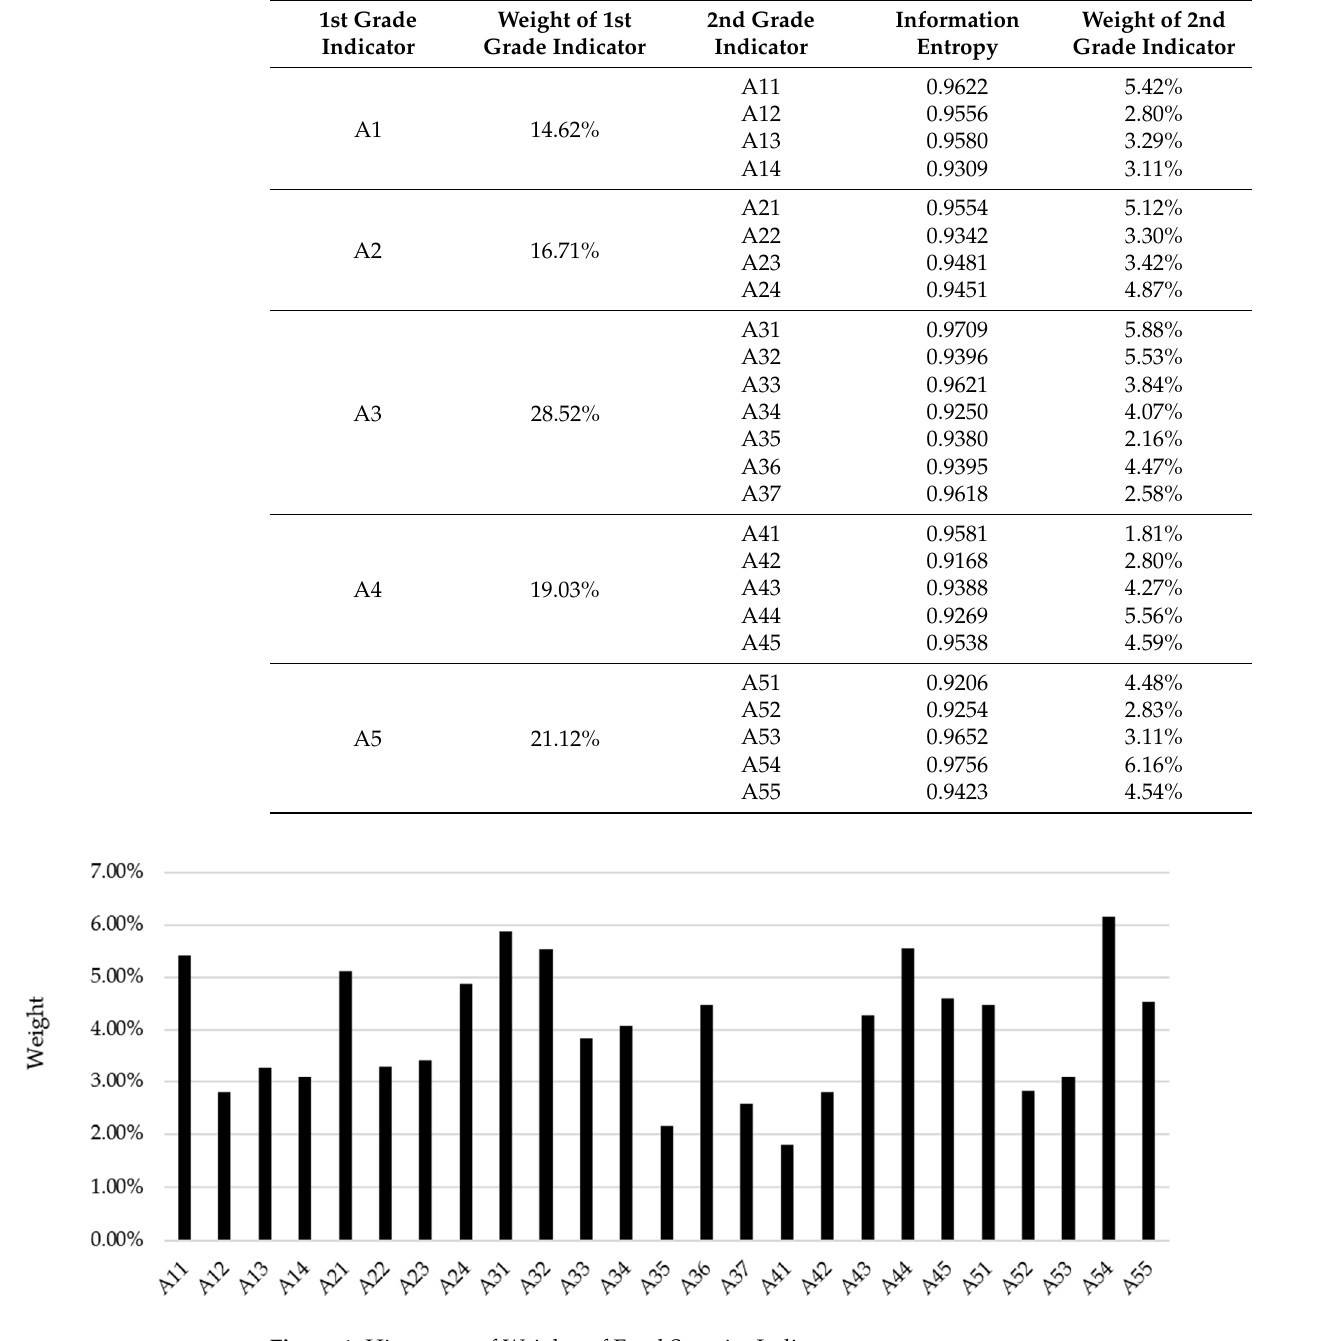
Figure 1. Histogram of Weights of Food Security Indicators.